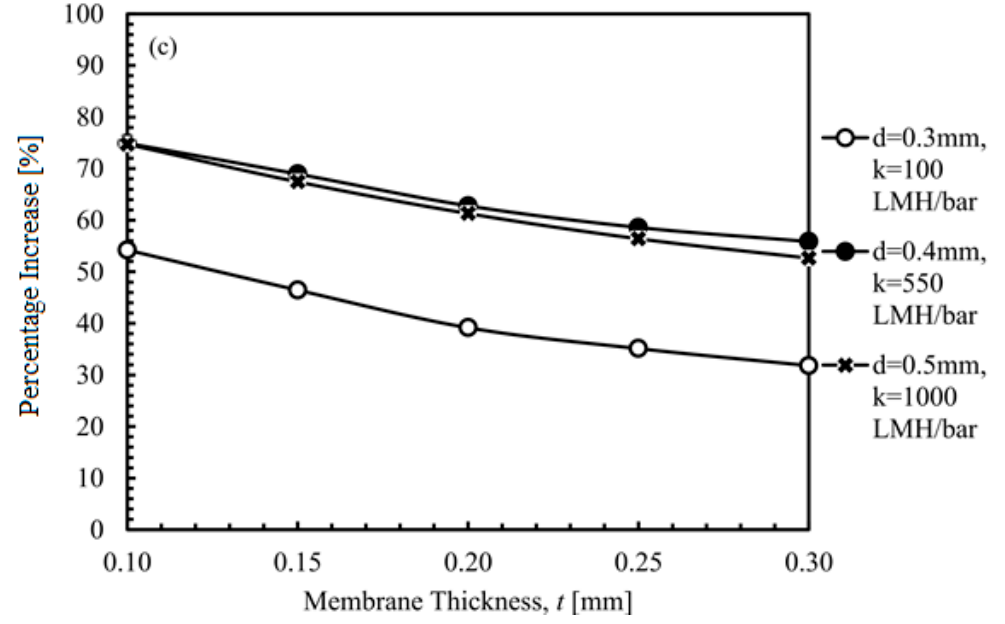
Figure 8. Relationship between membrane thickness and output flow rate for different fibre inner diameter and membrane permeability. ( a ) Single-end suction; ( b ) Double-end suction; ( c ) Percentage increase.